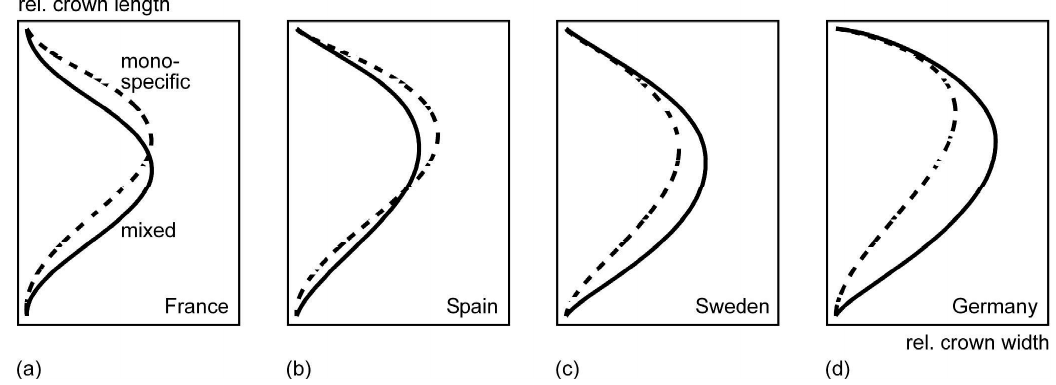
Figure 12. Height to crown base over tree height in mixed-species versus monospecific stands of ( a , b ) Scots pine and sessile/common oak and ( c , d ) Scots pine and European beech. The curves represent the mean (solid lines) and 95% quantile (thin lines) regression analyses of the hcb-h relationship. The thin bisector line indicates the minimum crown length (hcb = h). The analyses are based on crown measurement in mixed and monospecific stands across Europe (see model 7 in Table 1).